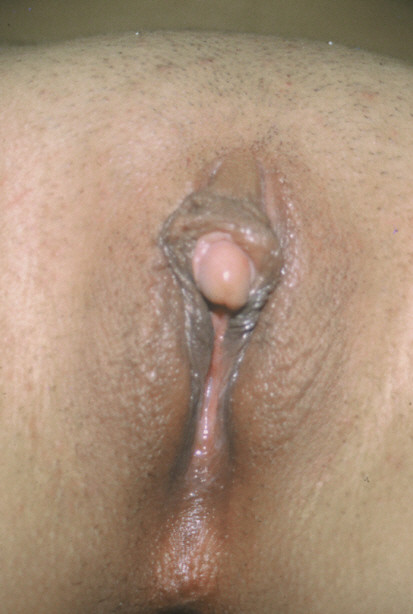
View of the Case 2.